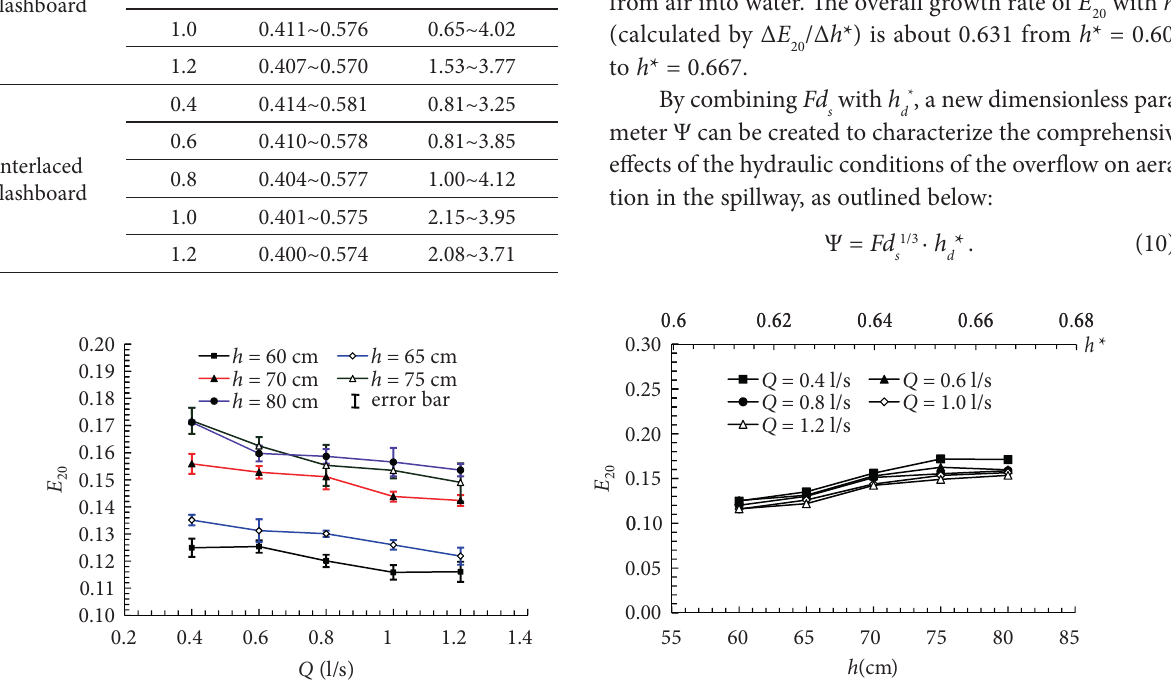
Fig. 3. Variation of oxygen-transfer efficiency E standard deviations of mean E